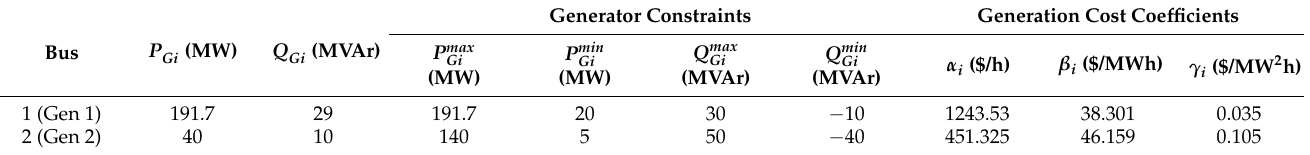
Figure 2. A single-line diagram of the IEEE 30-bus system [40]. Table 1. Generator data and cost coefficient [40].